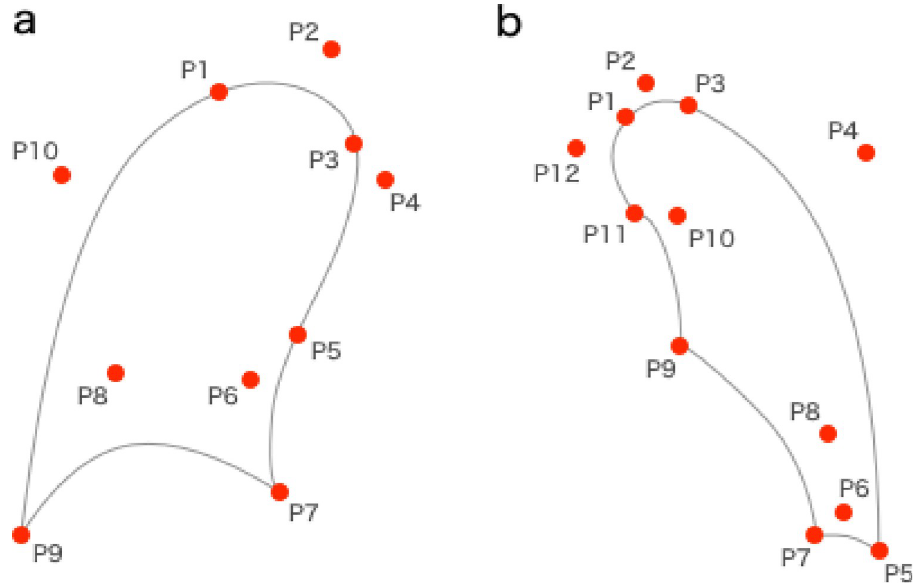
Fig 1. Setting of both lung fields.